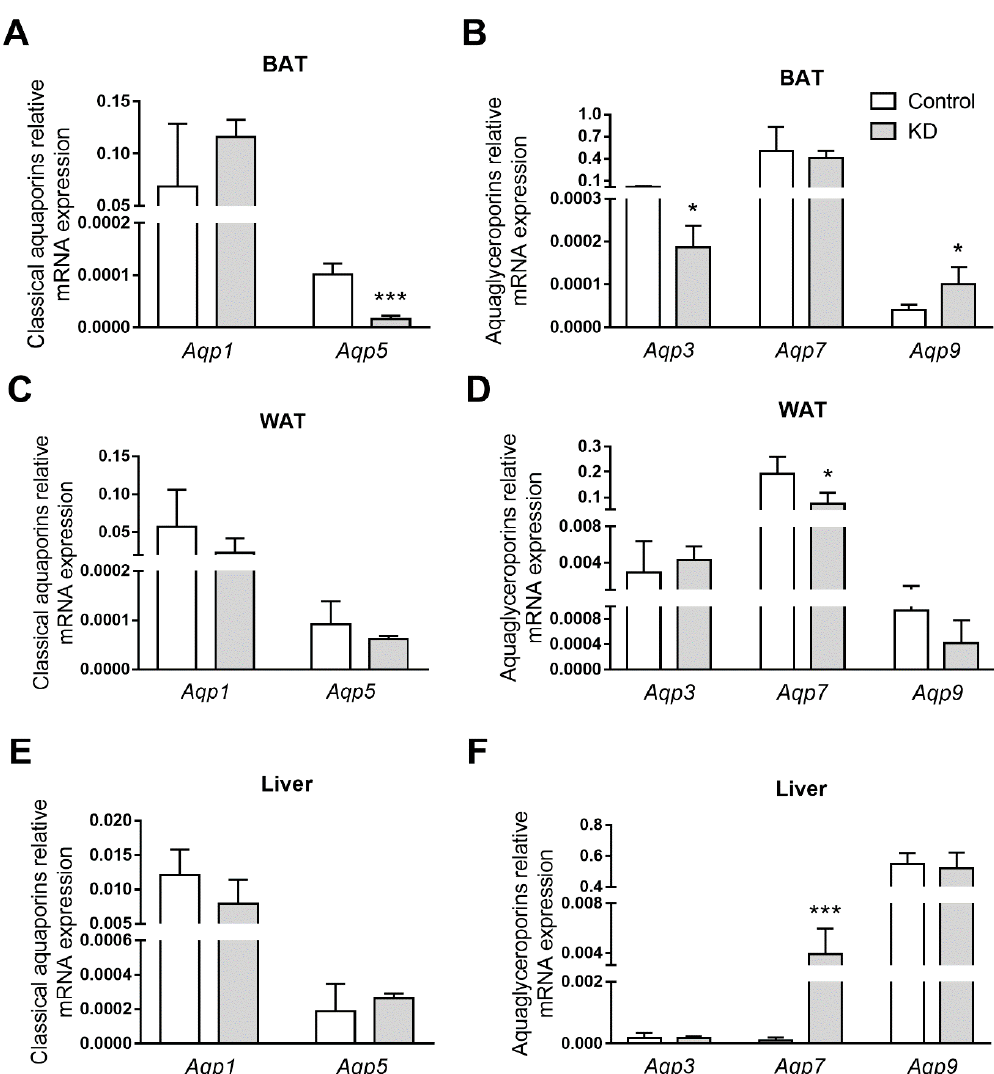
Figure 5. Aquaporin gene expression in ( A , B ) white adipose tissue (WAT), ( C , D ) brown adipose tissue (BAT), and ( E , F ) the livers of ApoE − / − mice fed control or a ketogenic diet (KD). Relative gene expression of ( A , C , E ) classical aquaporins and ( B , D , F ) aquaglyceroporins. Data shown are the mean ± SEM ( n = 6–8/group). *, p < 0.05; ***, p < 0.001, KD versus control .